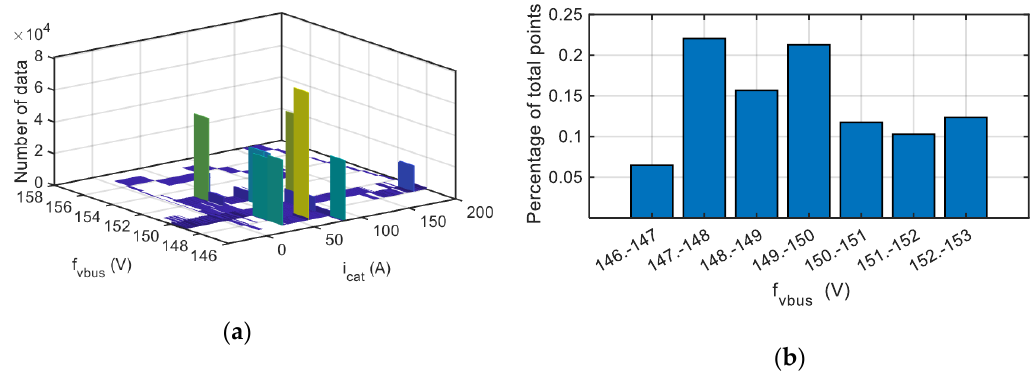
Figure 19. Visualization for a gain fault injected in the DC-link voltage sensor. ( a ) Histogram. ( b ) Percentage of points for each fault reconstruction interval.